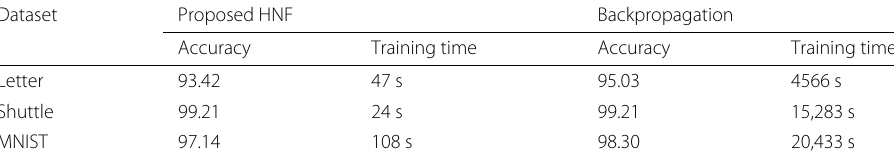
Table 3 Training time and test classification accuracy of the proposed HNF versus backpropagation